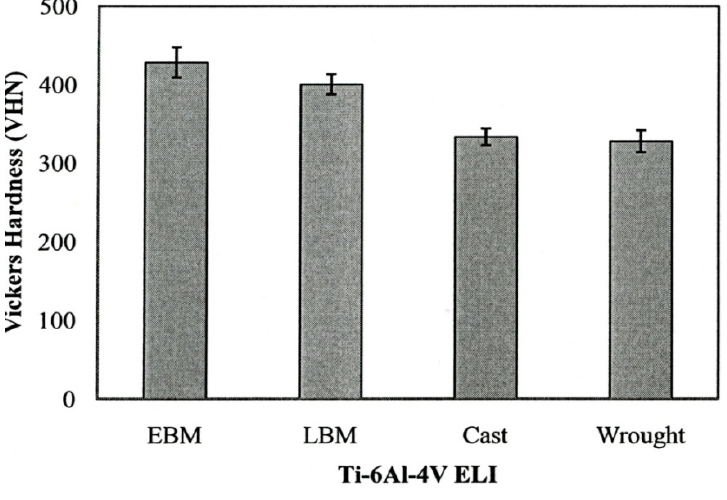
Figure 14. Bulk hardness of Ti-6Al-4V ELI specimens using different fabrication